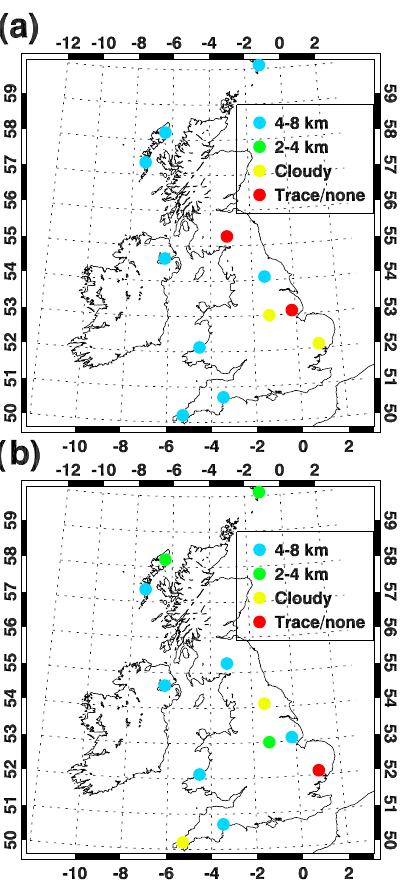
Figure 5. Aerosol observations by the Lufft CHM 15k ceilometers. (a) 23 May, (b) 24 May.